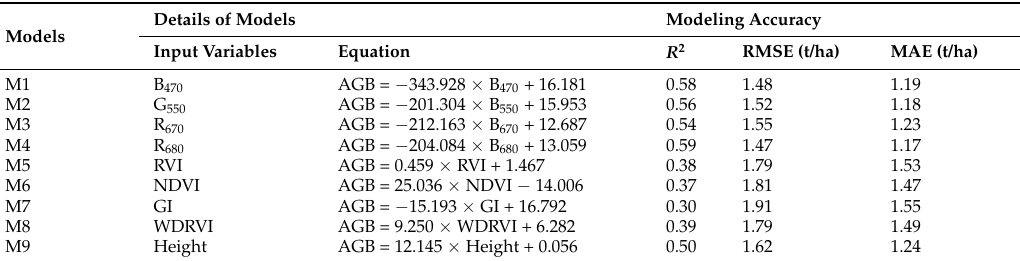
Table 3. Details of AGB estimate models.